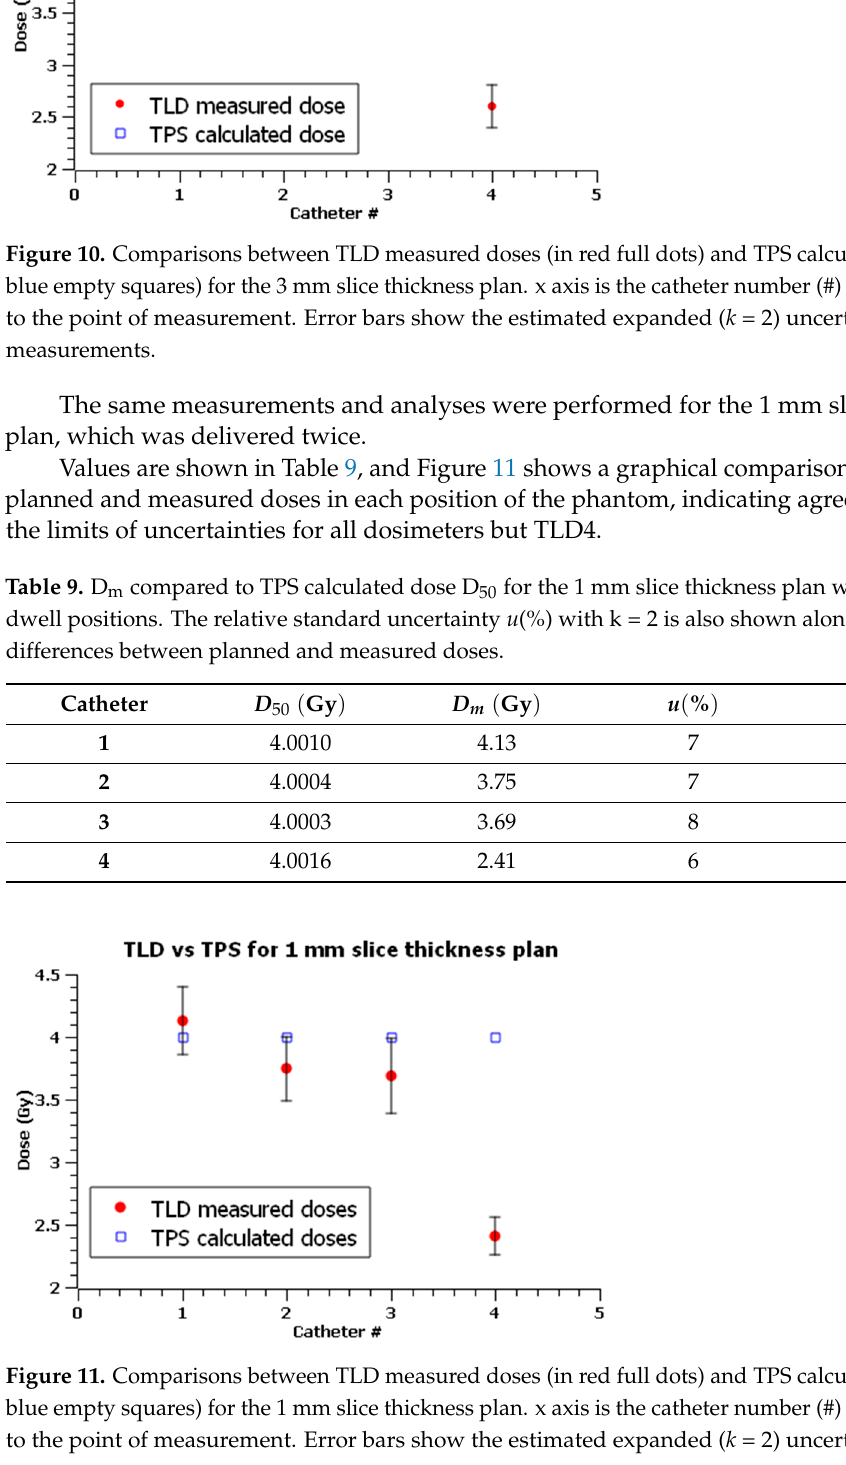
12 of 19 Table 8. D (cid:2923) compared to TPS calculated dose D (cid:2873)(cid:2868) for the 3 mm slice thickness plan with four ac- tive dwell positions. The relative standard uncertainty u(%) with k = 2 is also shown along with percent differences between planned and measured doses.